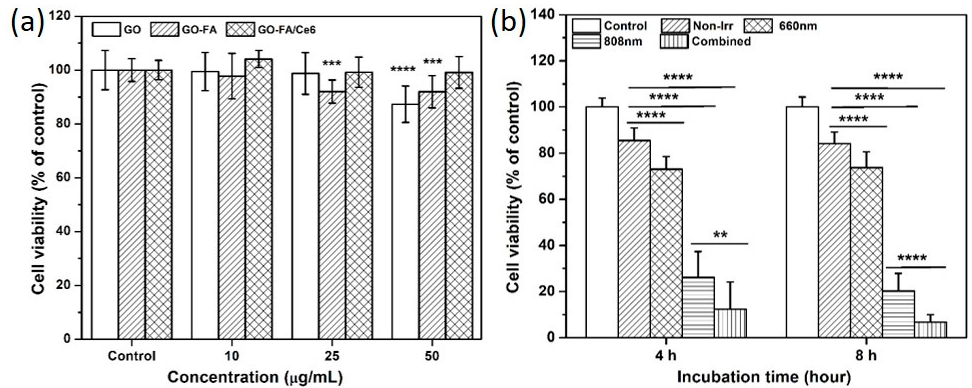
Figure 8. ( a ) Cytotoxicity of GO, GO–FA and GO–FA/Ce6 on RAW 264.7 macrophages after 24 h incubation and ( b ) comparison of RAW 264.7 cell viability following PTT, PDT and combined phototherapy after incubation with GO–FA/Ce6 for 4 and 8 h. Untreated RAW 264.7 macrophages were used as control. The results are expressed as the means ± SD ( n ≥ 3). The statistical analyses were performed by the Student’s t -test. * p < 0.05; ** p < 0.01; *** p < 0.001; **** p < 0.0001 compared with two groups.